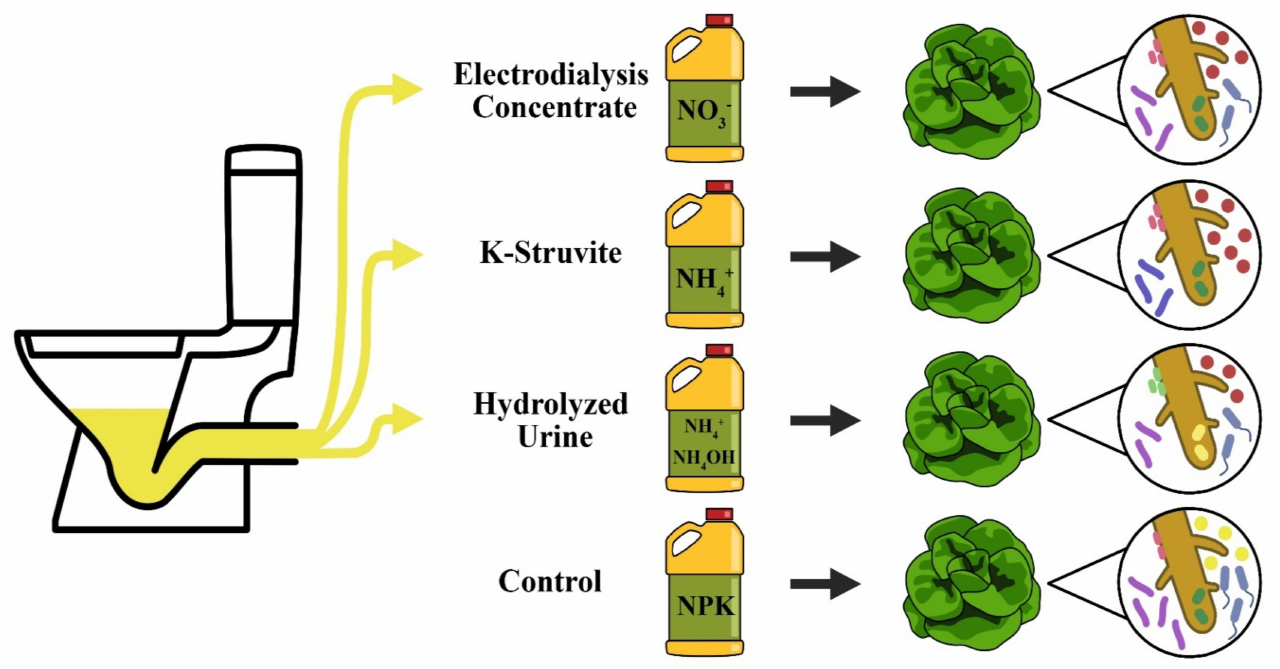
Figure 1. Schematic view of the experiment. Source-separated urine was converted into three urine-derived fertilizers: electrodialysis concentrate, K-struvite, and hydrolyzed urine. These urine-derived fertilizers were applied in a soilless culture of Lactuca sativa L. The plant phenotypes, physiological states, and root-associated bacterial communities were evaluated and compared to commercial mineral